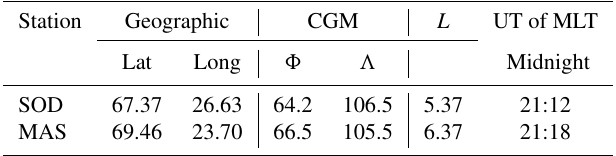
Table 1. Coordinates and other parameters of IMAGE